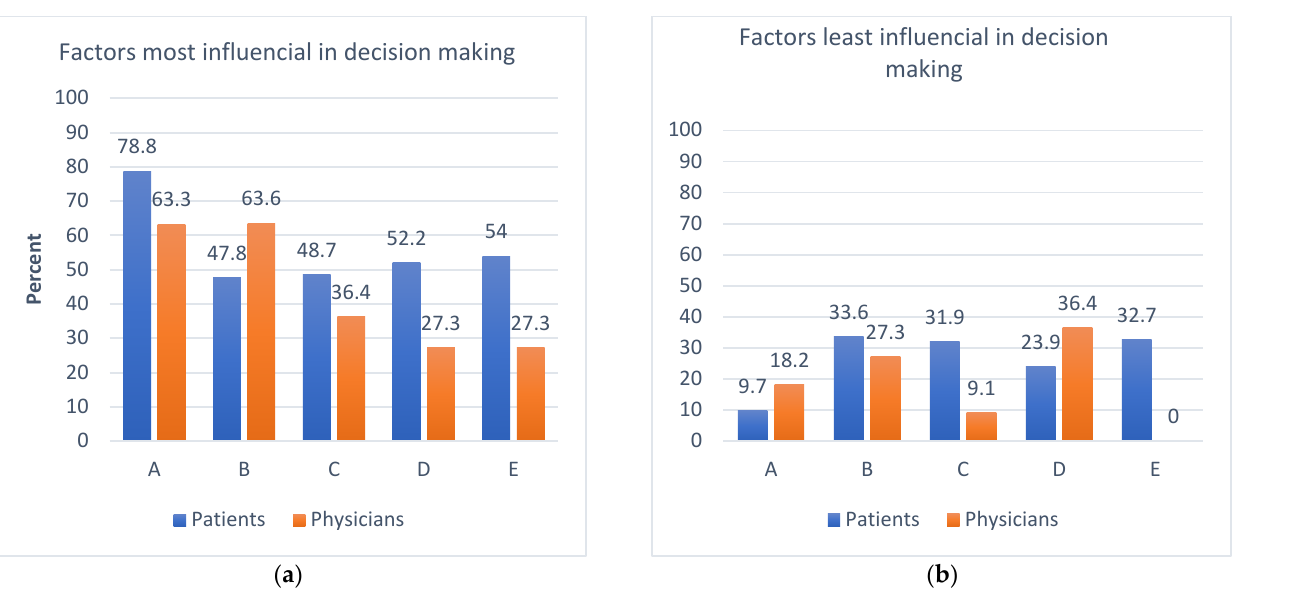
Table 2. Concordance rates (%) for patients’ and physicians’ responses to questions about their in- terests, attitudes, and expectations toward genomic testing.